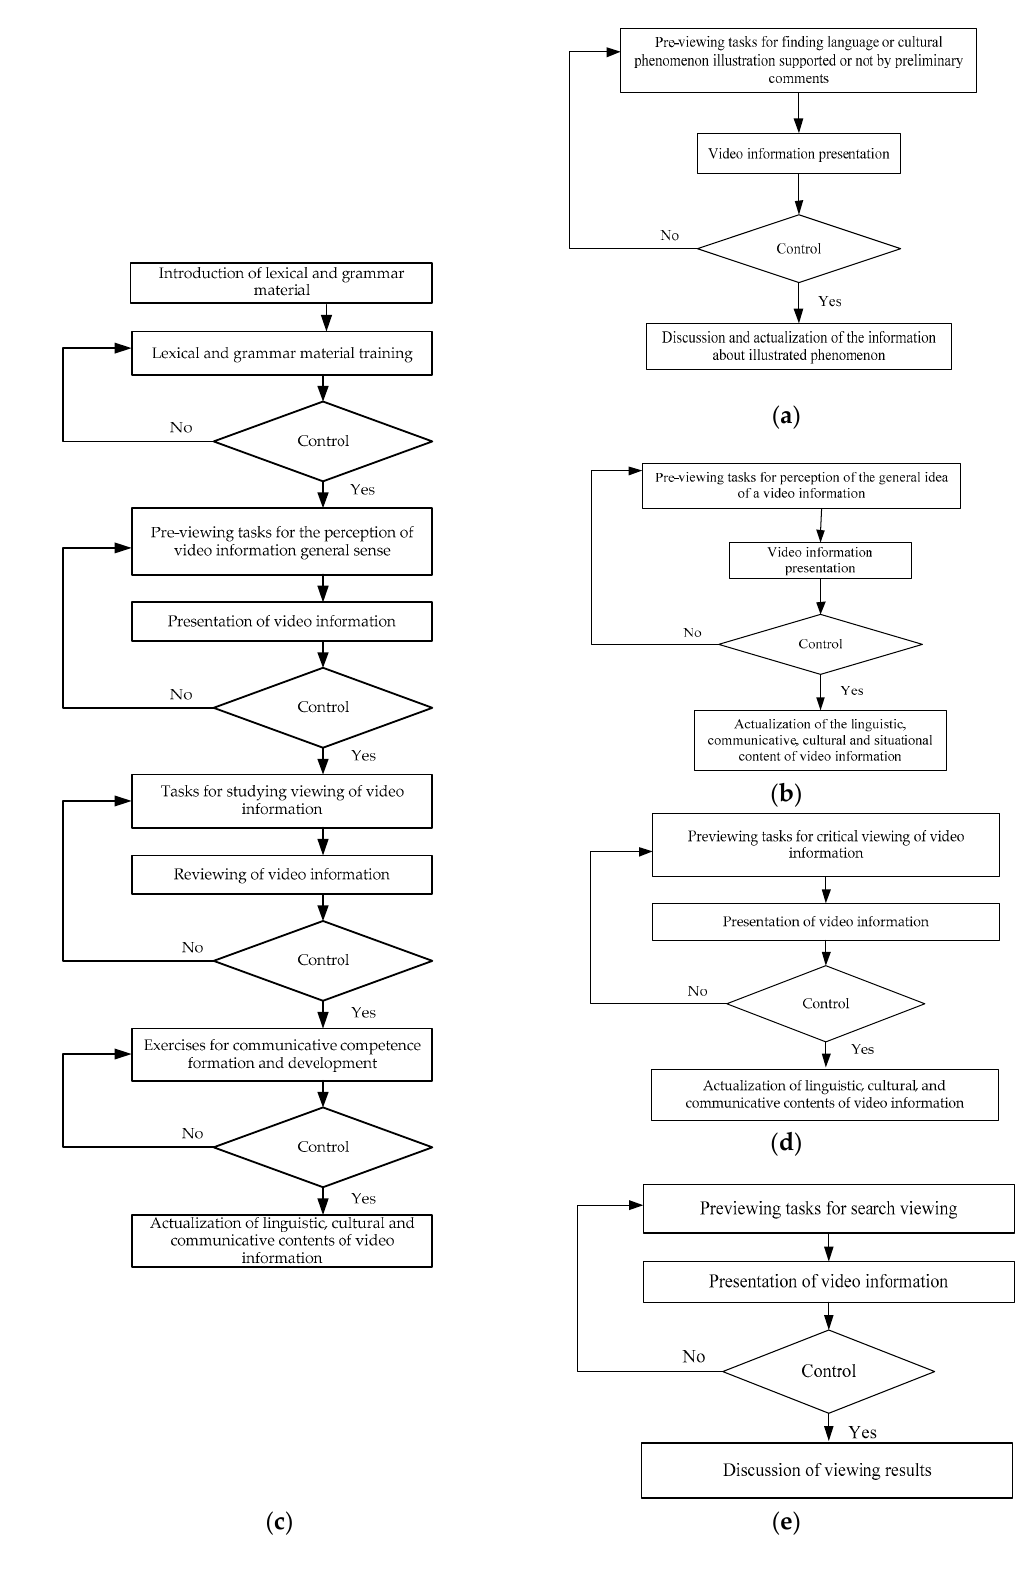
Figure 5. ( a ) Algorithm of foreign language training process based on video information ( illustrative viewing ); ( b ) Algorithm of foreign language training process based on video information ( fact-finding viewing ); ( c ) Algorithm of foreign language training process based on video information ( studying viewing ); ( d ) Algorithm of foreign language training process based on video information ( critical viewing ); ( e ) Algorithm of foreign language training process based on video information ( search viewing ).